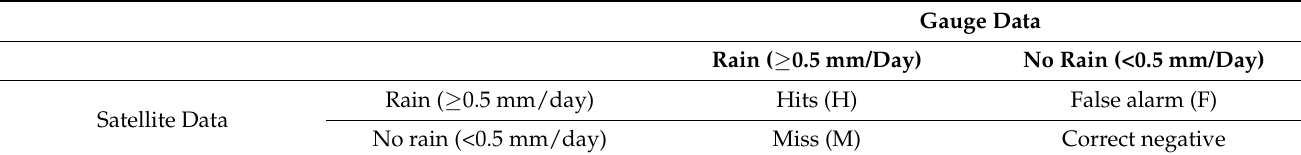
Table 5. Precipitation contingency table between precipitation gauged data and SPDSs.